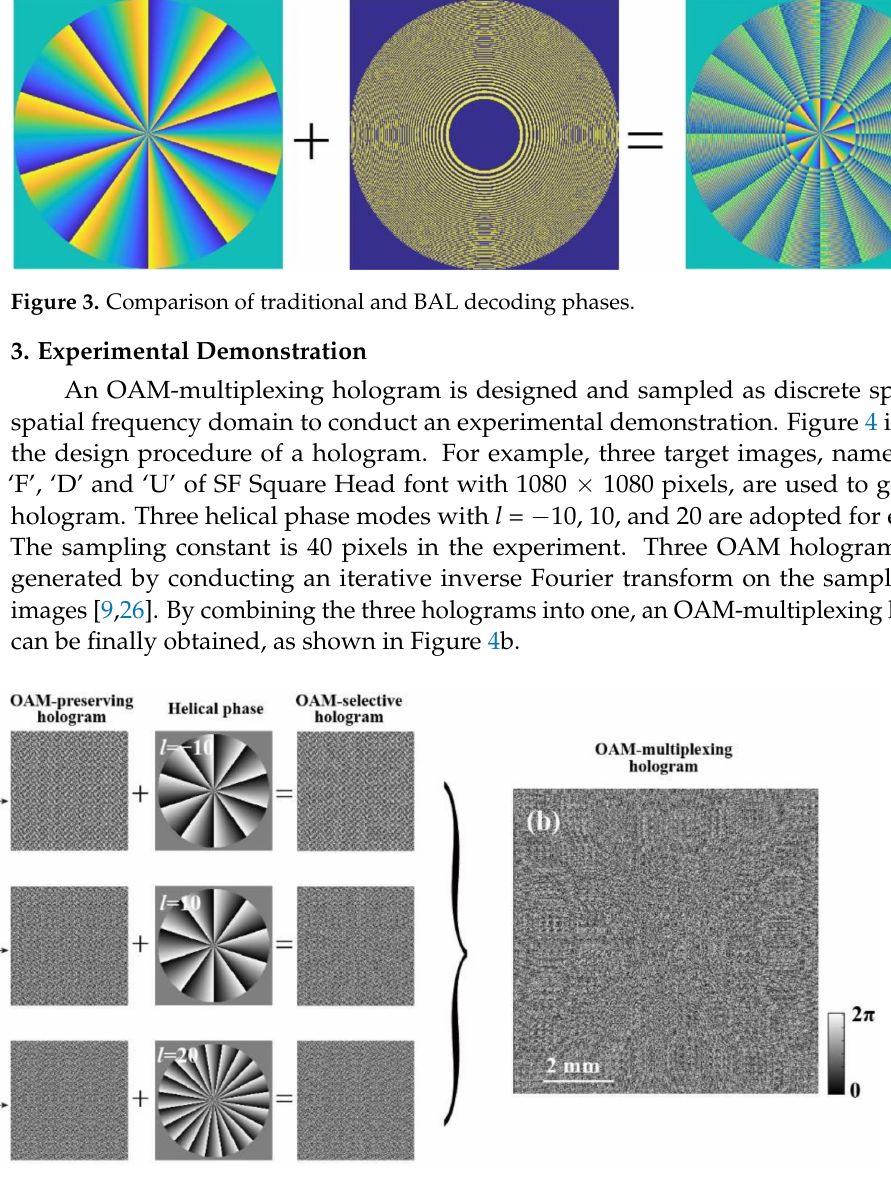
Figure 4. Generation of an OAM-multiplexing hologram. ( a ) The design procedure. ( b ) The generated